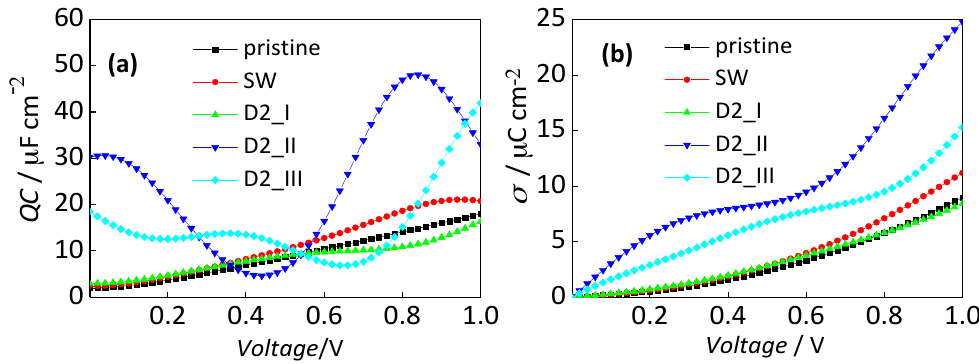
Figure 2. Energy storage performance of pristine and graphene with Stone–Wales (SW) and D2 defects. ( a ) quantum capacitance (QC) and ( b ) excessive surface charge density (ESCD).